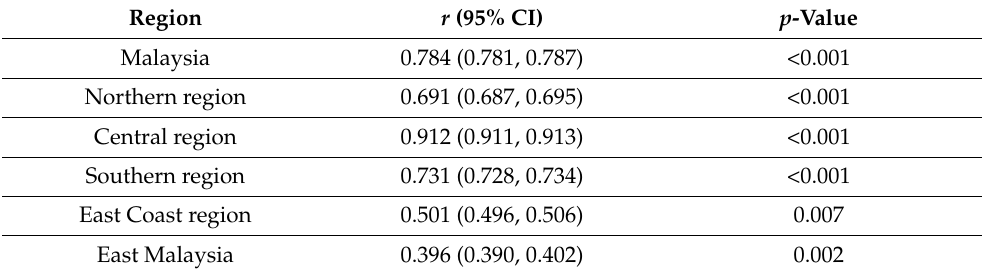
Figure 3. Choropleths showing district-wise heat distribution based on ( A ) population density (comparator); ( B ) infected people per km 2 . Table 1. Correlation between active COVID-19 cases and population